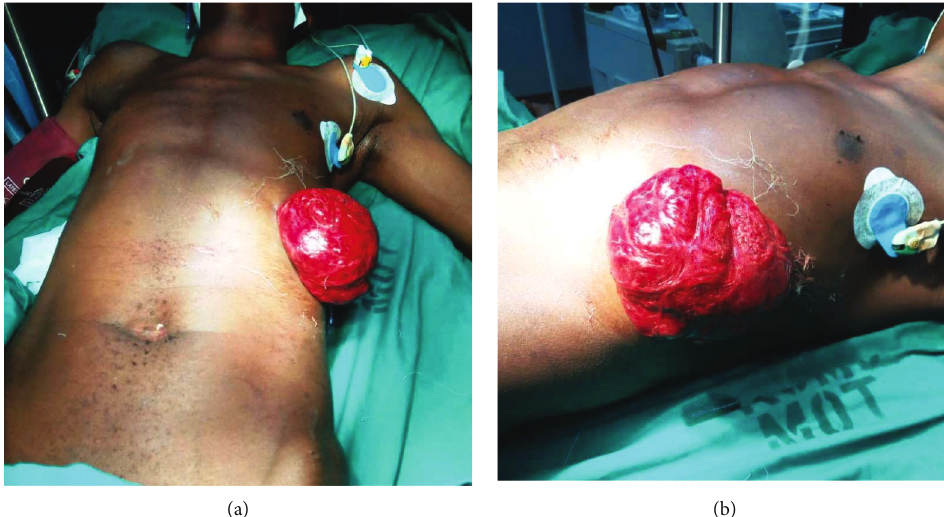
Figure 4: (a and b) Eviscerated omentum with bowels in a patient who sustained penetrating abdominal injury from knife stab wound on his left hypochondriac area. He also sustained diaphragmatic laceration which was repaired through abdominal